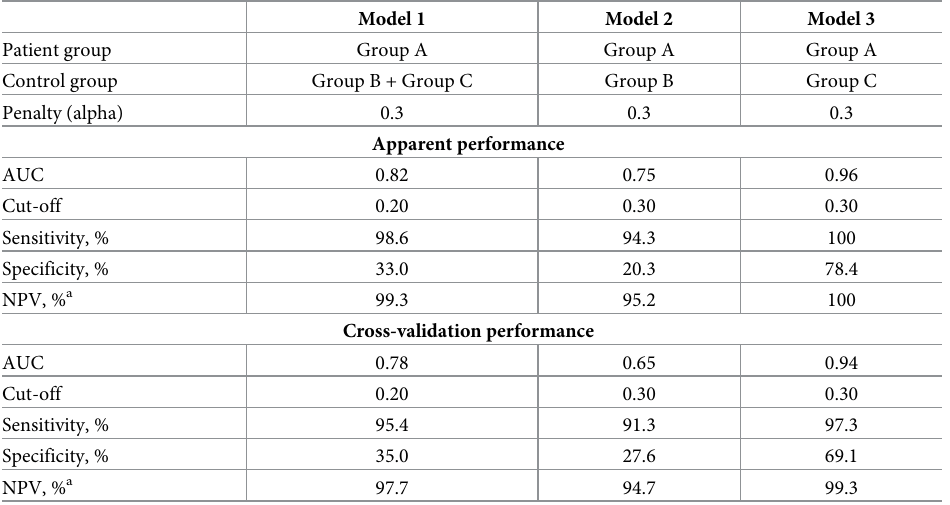
Table 3. Apparent and cross-validation performance of the logistic regression models.